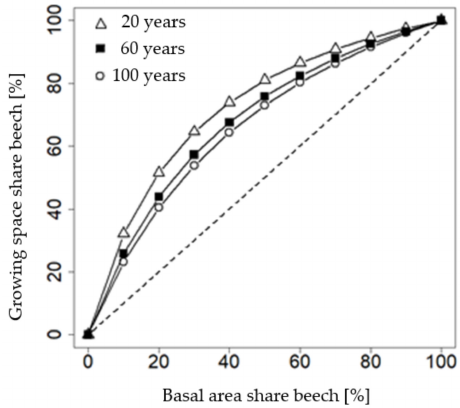
Figure 5. Conversion between growing space share ( α ) and basal area share ( β ) in a mixed stand of European beech ( be ) and Norway spruce ( sp ). Each line presents one stand age ( t ): triangle = 20 years, square = 60 years, circle = 100 years. α was calculated as α 1 from Equation (11) and as dependent on the basal area share given as β 1 in Equation 11. The diameter at breast height in Equation (2) was taken according to the stand age (Figure 2); parameters c 1 and c 2 in Equation (11) were taken from Table